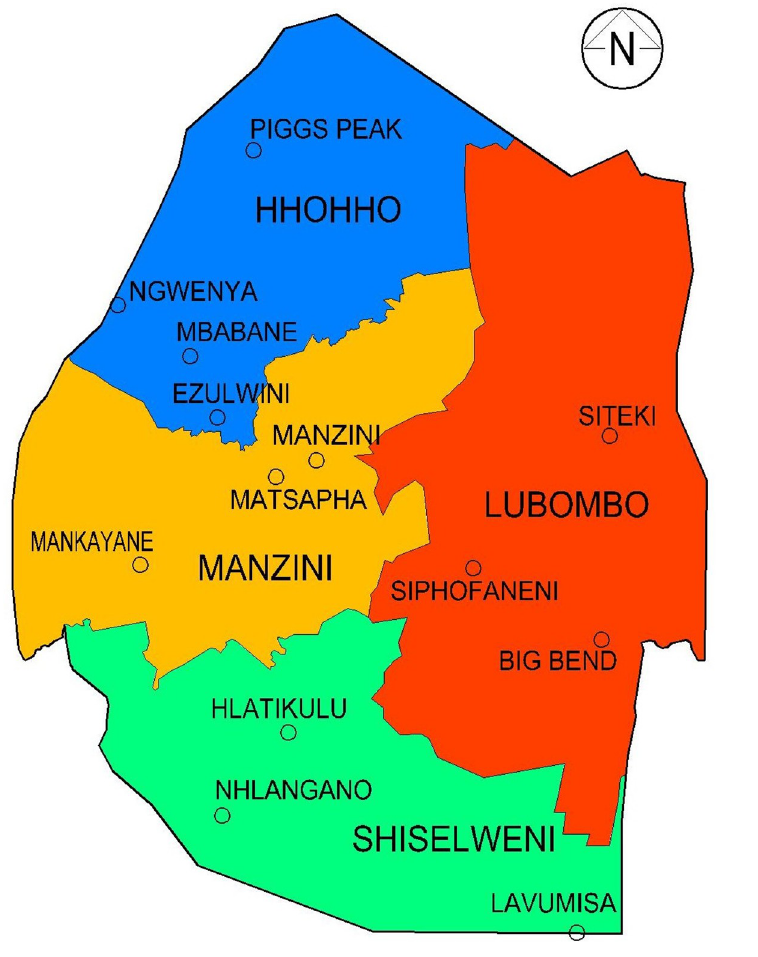
Fig 1. Regions and Towns of